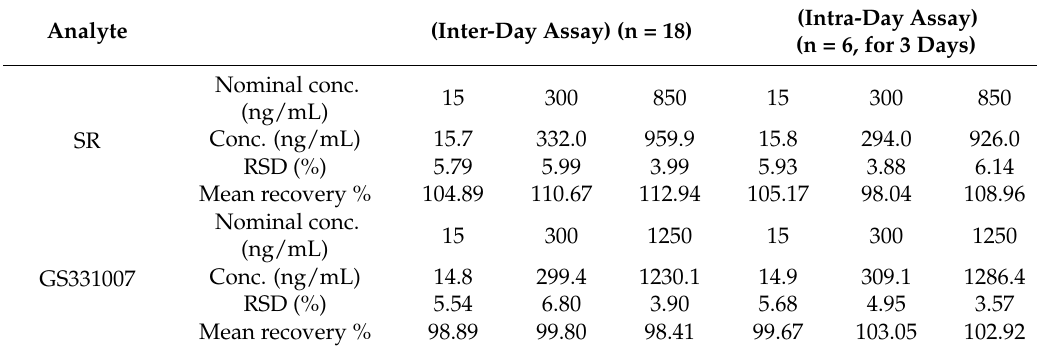
Table 2. Intra- and inter-day accuracies and precisions of sofosbuvir and GS331007 in plasma.